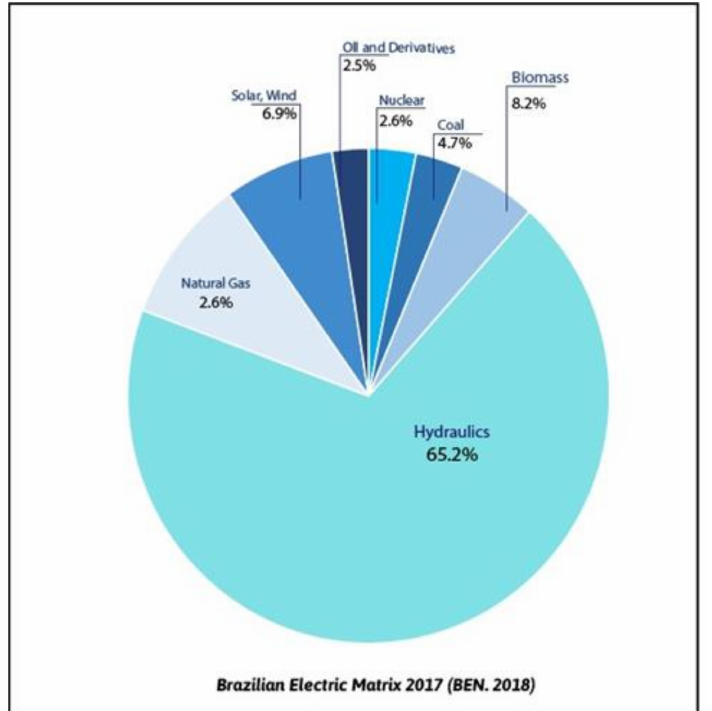
Figure 3. Brazilian and world electrical matrix. Source: adapted from EPE (2019)